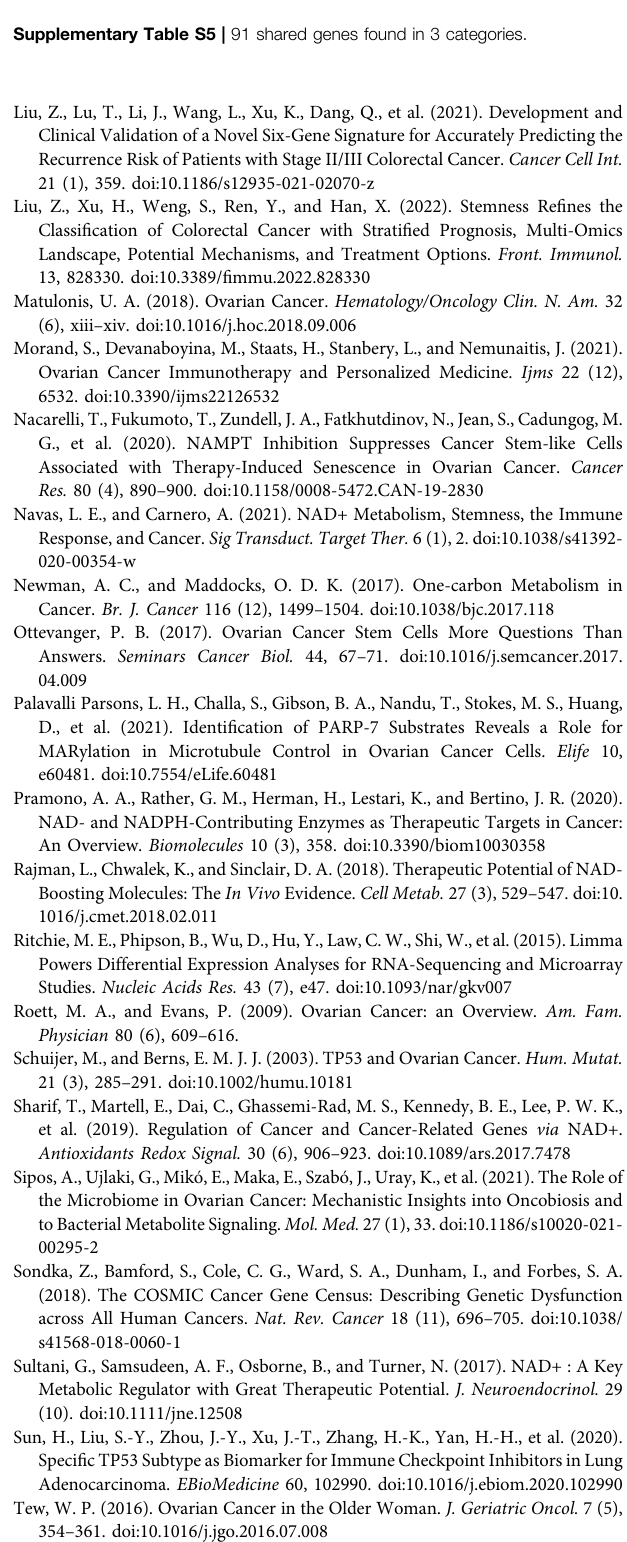
Supplementary Table S3 | NAD + metabolism-related genes. Supplementary Table S4 | Clustering characteristics of patients. Supplementary Table S5 | 91 shared genes found in 3